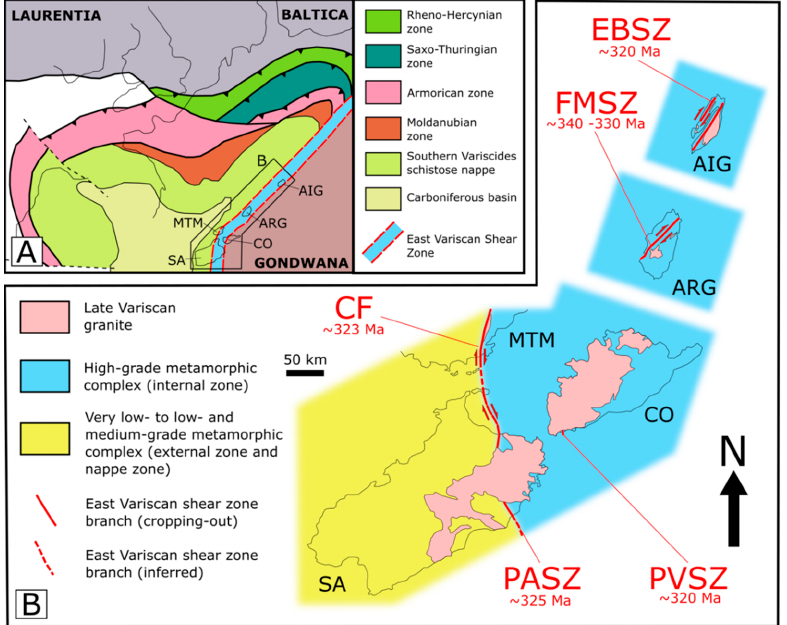
Figure 1. ( A ) Sketch maps of the Southern European Variscan belt during the late Carboniferous (modified from Faure et al., 2005 [20]; Corsini and Rolland, 2009 [21]; Guillot and Ménot, 2009 [22]); ( B ) inferred lateral relationships between the branches of EVSZ during the late Carboniferous (mod- ified from Simonetti et al., 2020 [23]). SA = Sardinia; MTM = Maures–Tanneron Massif; CO = Corsica; ARG = Argentera Massif; AIG = Aiguilles Rouge Massif; PASZ = Posada–Asinara Shear Zone; CF = Cavalaire Fault; PVSZ = Porto Vecchio Shear Zone; FMSZ = Ferriere–Mollières Shear Zone; EBSZ = Emosson–Berard Shear Zone.